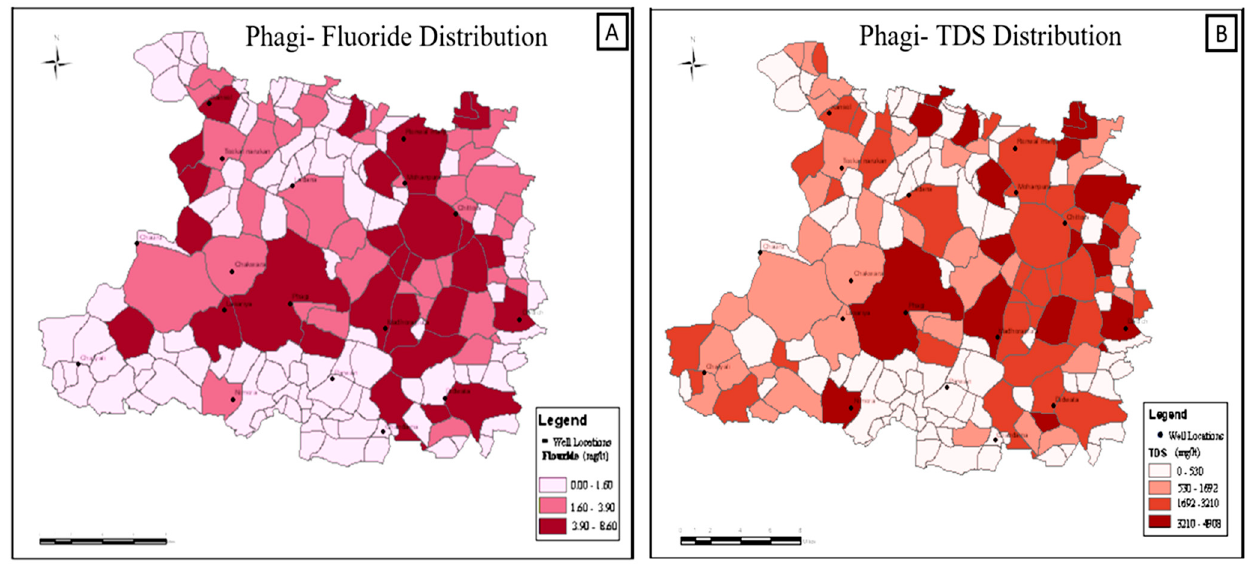
Figure 4. Spatial distribution of TDS ( A ) and Fluoride ( B ) concentration in Phagi Tehsil (Source—Primary Data).